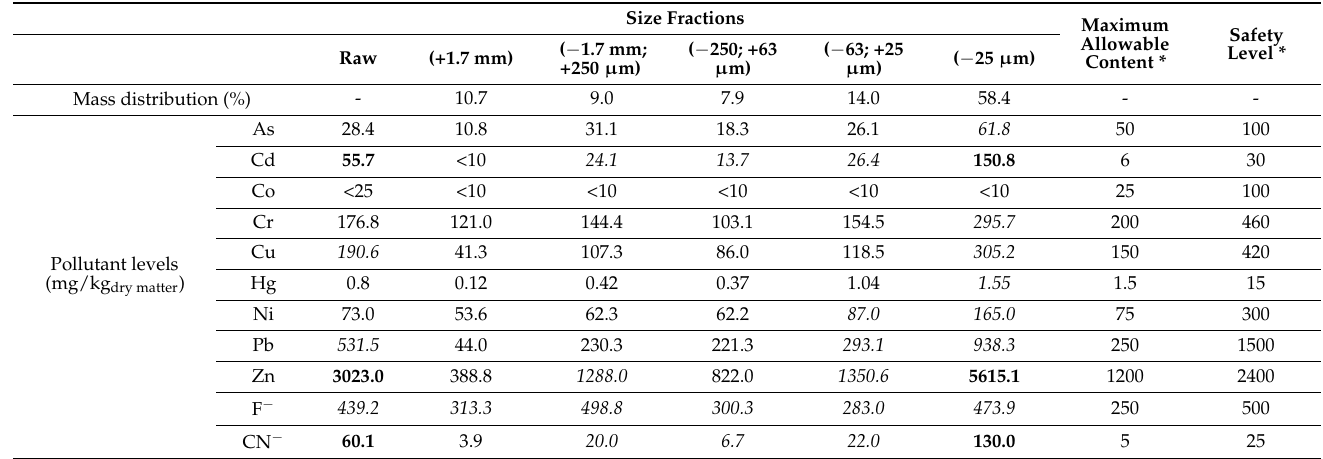
Table 3. Mass content distribution and inorganic pollutant level distribution inside SLS sediment compared to the thresholds specified in [42].